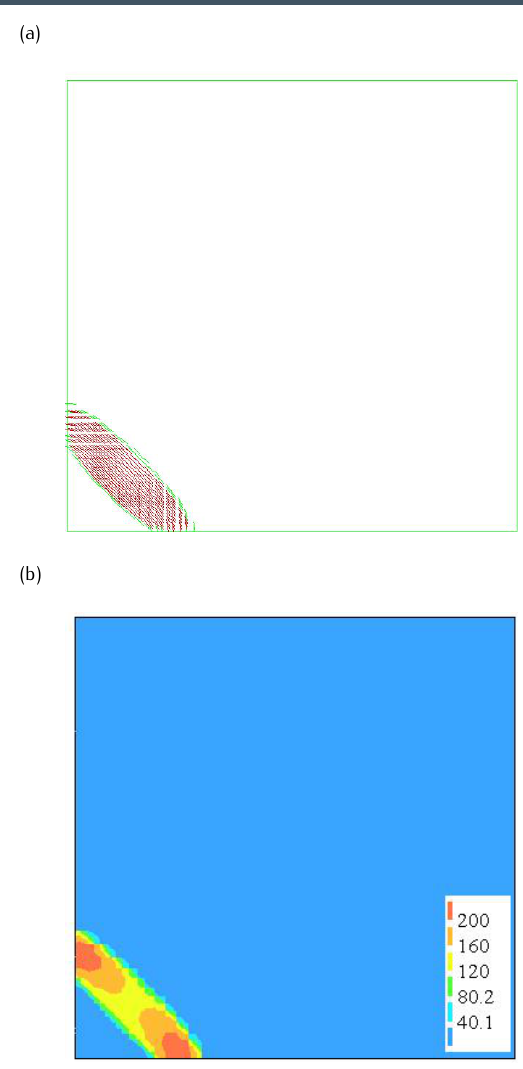
Figure 21. Corner load, (a) Crack pattern at top surface at 40 kN, (b) Distribution of stresses [N/mm 2 ] in the top layer of reinforcement at 40